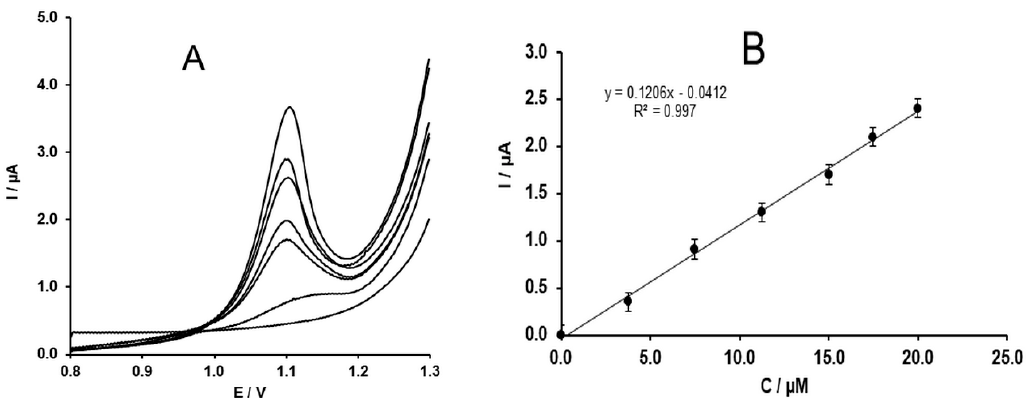
Figure 8. ( A ) DPV of SIM recorded at different concentrations (0, 3.75, 7.5, 11.25, 15, 17.5, and 20 µM); ( B ) concentration dependence of the SIM oxidation peak current.